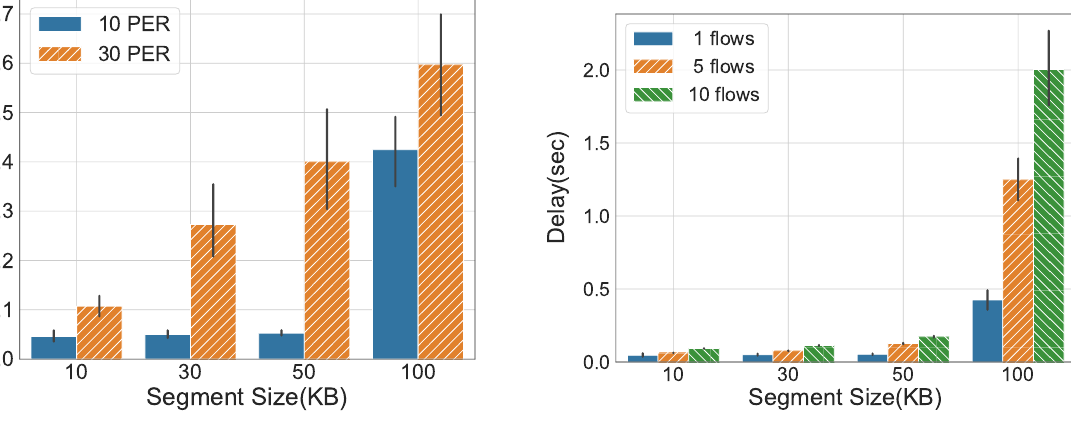
Figure 11. Delay of multi-hop payment with varying segment